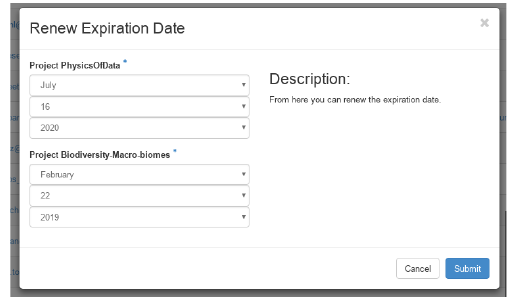
Figure 3. The architecture of CloudVeneto.it. Table 1. CloudVeneto.it computing resources.